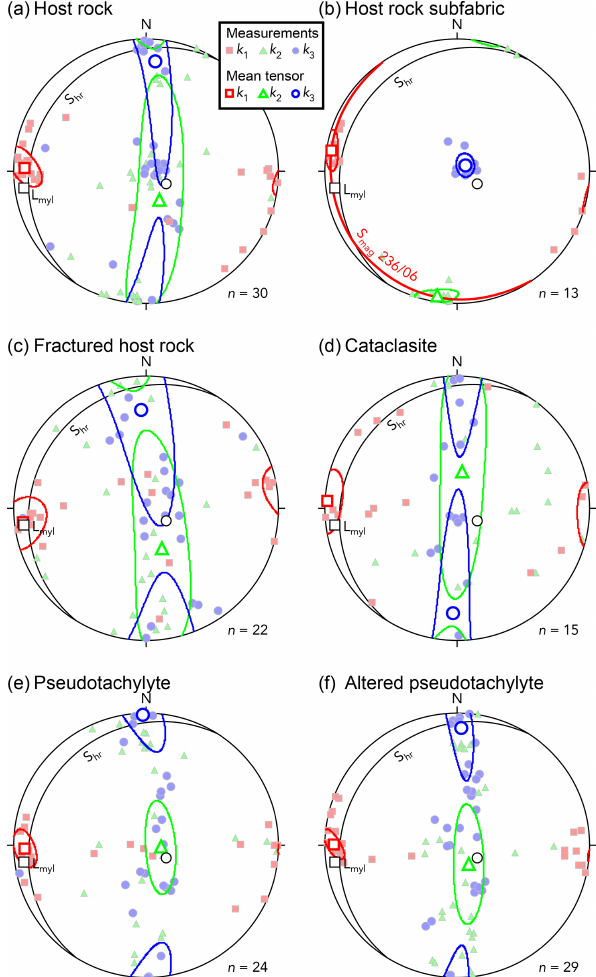
Figure 6. (a–f) Lower-hemisphere equal-area projections for prin- cipal axes of magnetic anisotropy in different rock types. Comments about data presentation follow: (a) the measurement for specimen AB15-75 was excluded because it was considered an outlier due to its high k m (see also Table 1). (e) All data for specimens contain- ing ≥ 50% pseudotachylyte were plotted. (f) All data for specimens containing ≥ 50% altered pseudotachylyte were